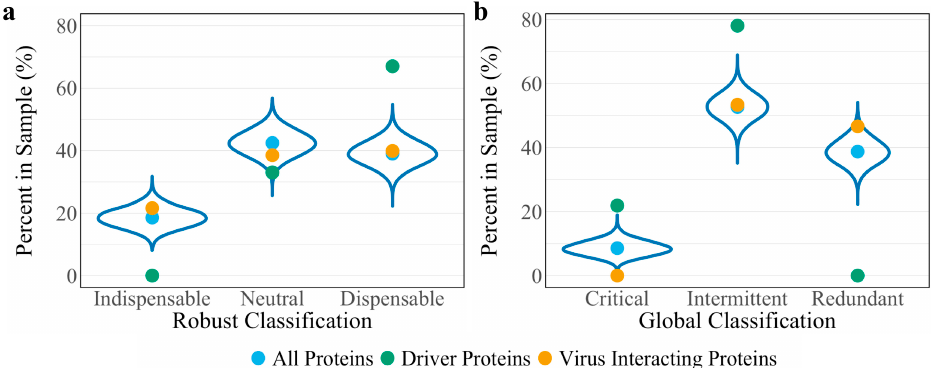
Figure 2. Distributions of controllability classification results of 10,000 random “pseudo-virus interacting” protein sets for ( a ) robust controllability and ( b ) global controllability. True values for all proteins (blue), driver proteins (green), and virus interacting proteins (yellow) of the VIN are shown as reference for each classification.